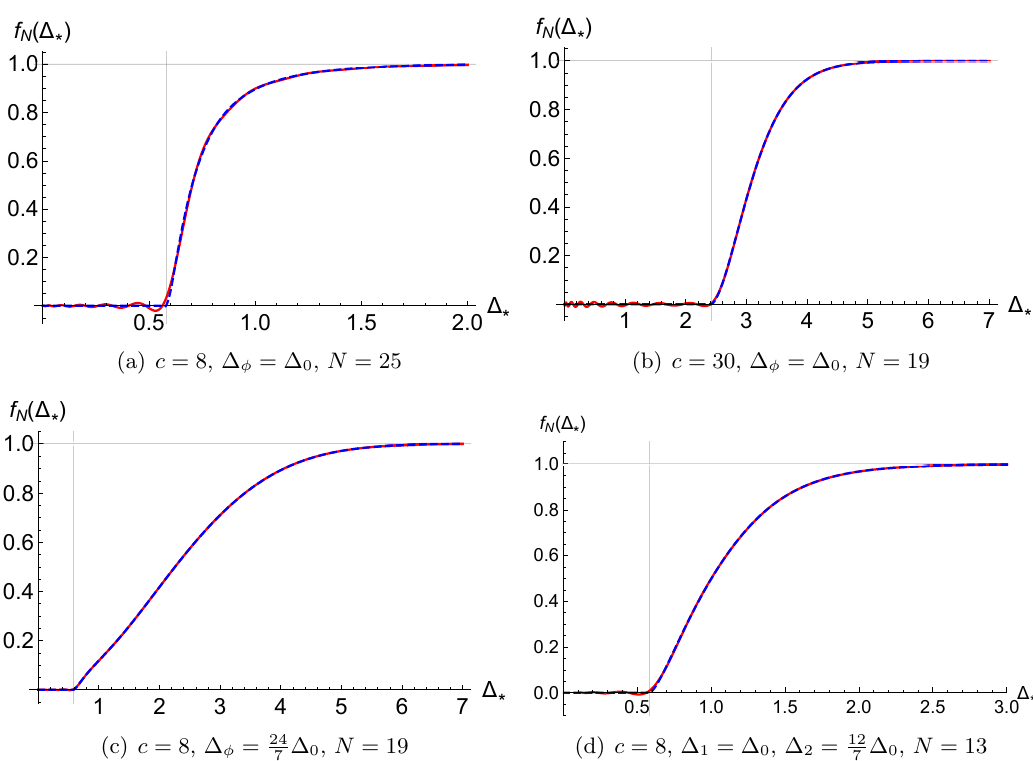
Figure 4 . Comparison of f N ((cid:1) (cid:3) ) (solid, red) with the exact DOZZ spectral function (dashed, blue) for external operator dimension (cid:1) (cid:30) , and in the mixed correlator case, external operator dimensions